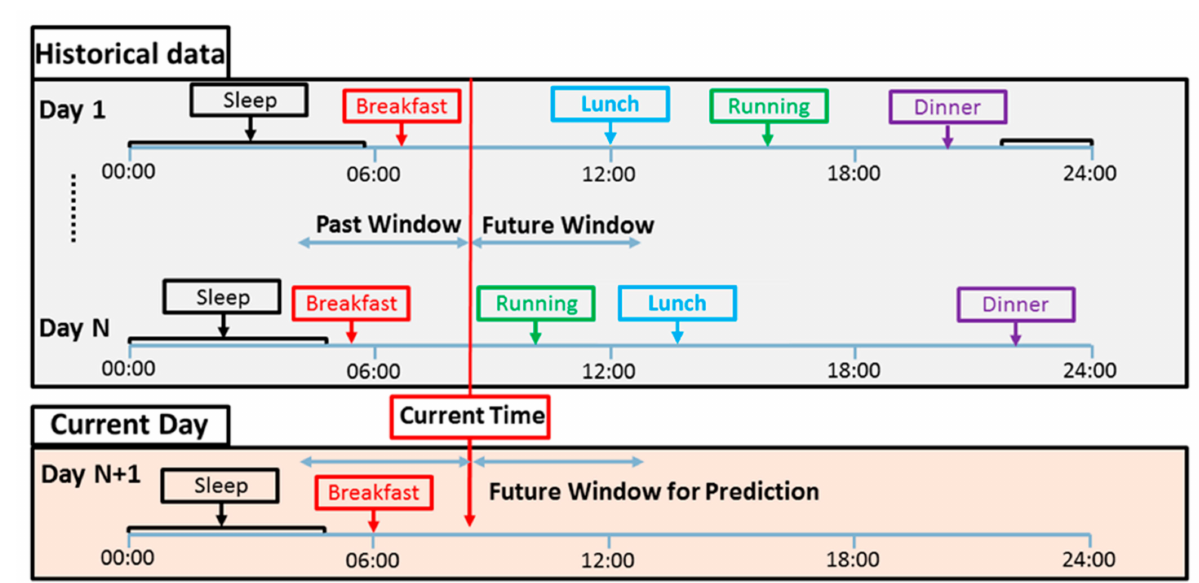
Figure 9. Disturbance prediction from historical data